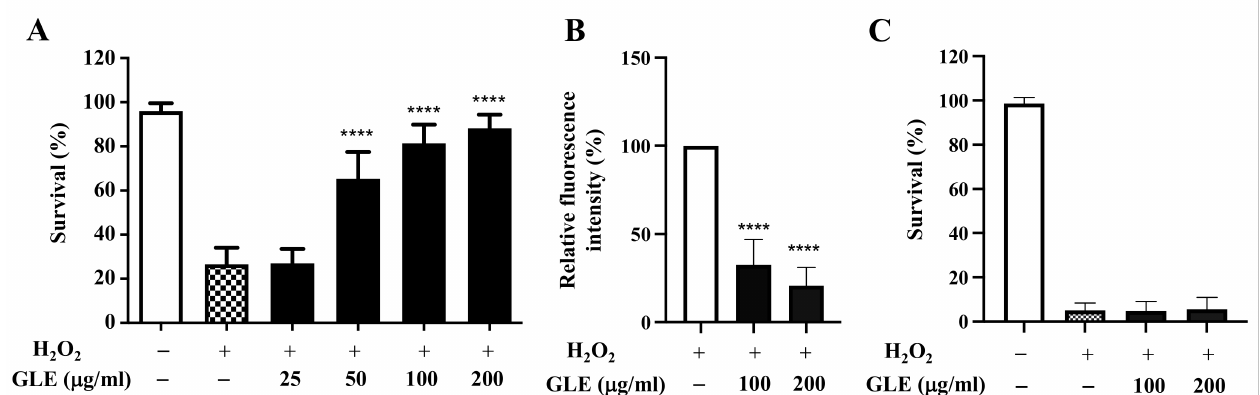
Figure 1. Effect of Glochidion litorale leaf extract (GLE) on stress resistance in wild-type and daf-16 mutant Caenorhabditis elegans . ( A ) Effect of GLE against H 2 O 2 -induced toxicity in wild-type worms. ( B ) Intracellular reactive oxygen species (ROS) contents in wild-type worms. ( C ) Effect of GLE against H 2 O 2 -induced toxicity in daf-16 mutant worms. Experiments were performed in triplicate. Data are presented as mean ± standard deviation (SD). **** p < 0.0001 compared to H 2 O 2 - treated